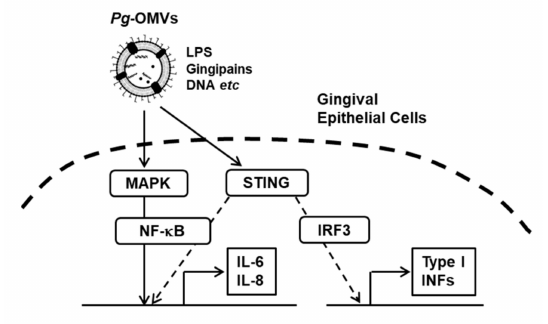
Figure 7. A schematic diagram showing the proposed pathway in Pg -OMV-induced IL-6 and IL-8 expression in human gingival epithelial cells. Pg -OMVs contain various virulence factors, such as LPS and gingipains. Pg -OMVs activate Erk1/2, JNK, p38 MAPK, STING, and NF- κ B signaling pathways, leading to increased IL-6 and IL-8 expression in human gingival epithelial